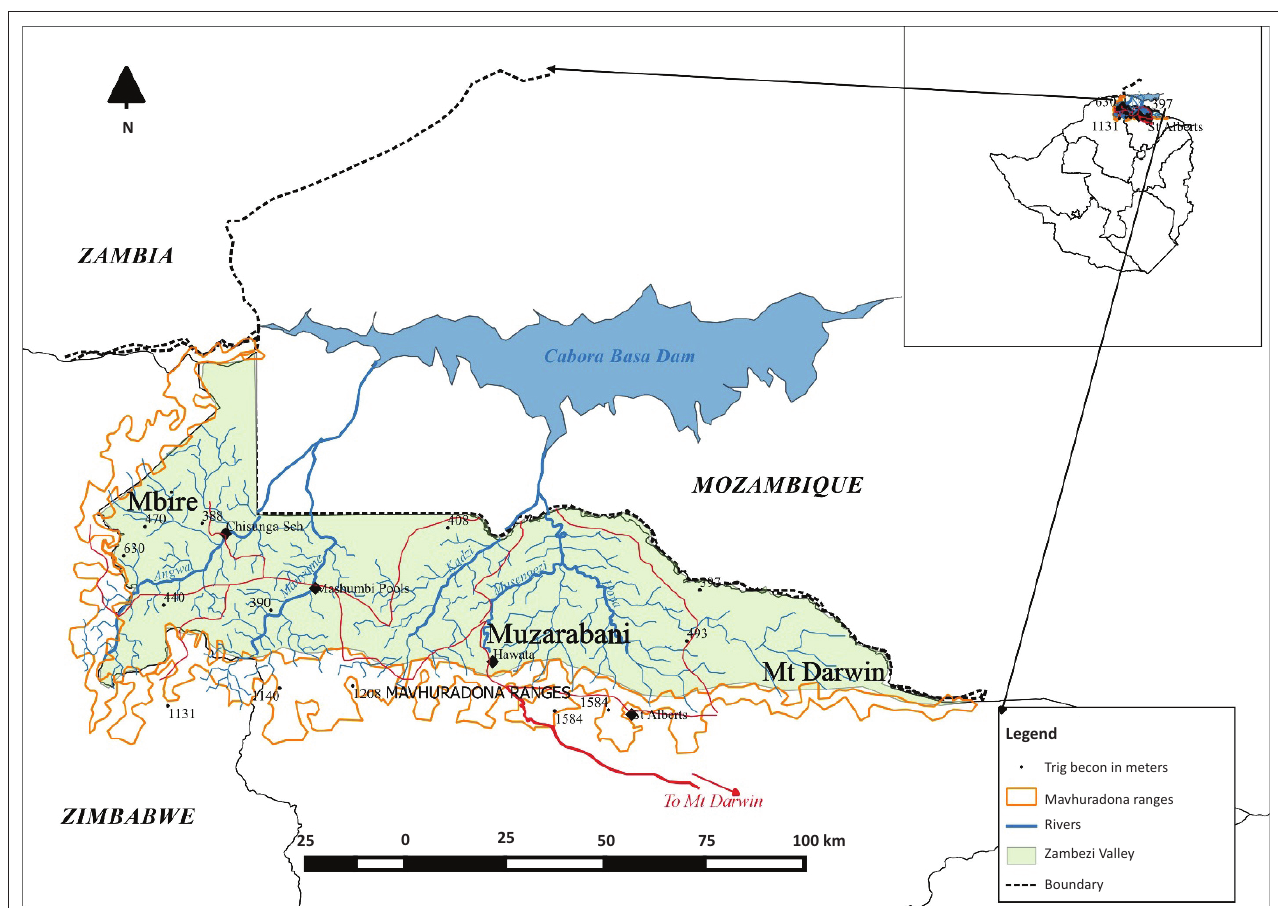
FIGURE 1: Map of the Zambezi Valley,